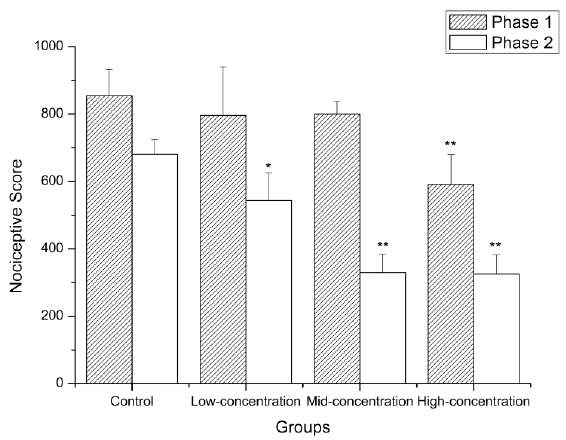
Figure 3. Analgesic effects of wICM in formalin test. Data are expressed as the means ± SD. * shows p < 0.05 compared with the control group; ** shows p < 0.01 compared with the control group.